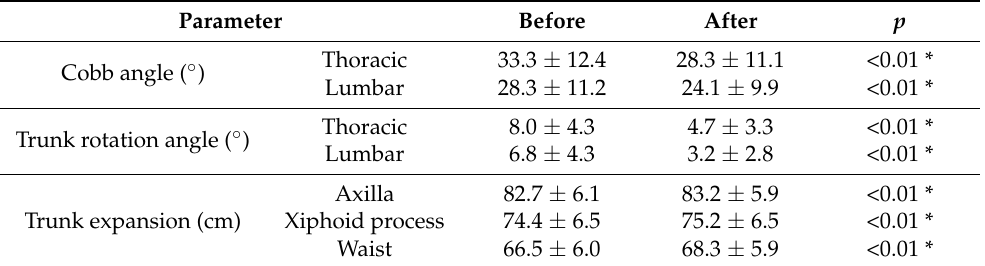
Table 5. Comparison of parameters before and after the 3DPC exercise program ( n = 37). Parameter Before After p Cobb angle ( ◦